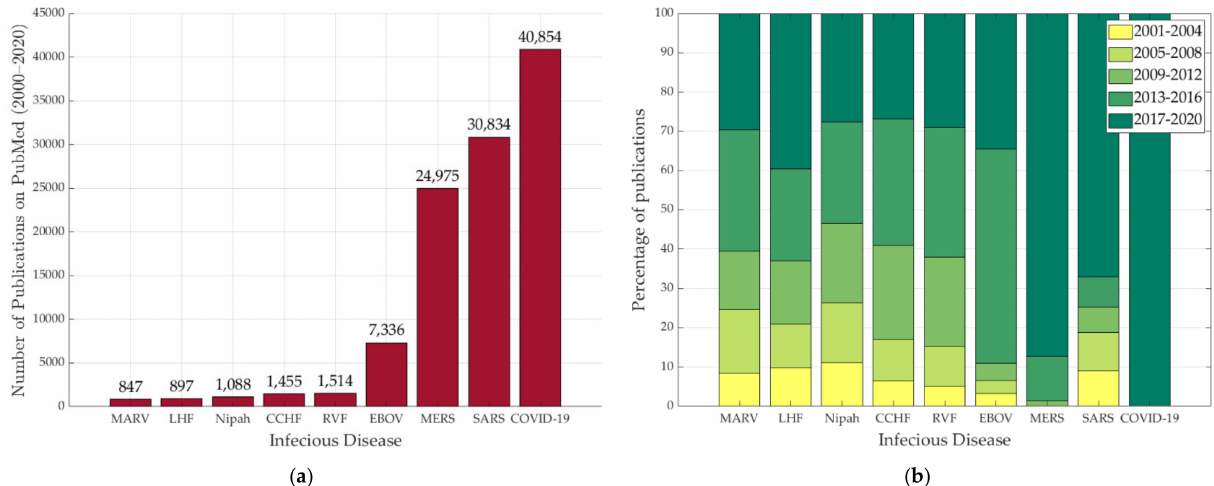
Figure 1. Statistics on publications for each disease for the period of 2000–2020, (Source: PubMed search results; search terms: “COVID–19”, “severe acute respiratory syndrome”, “middle east respiratory syndrome”, “ebola virus disease”, “rift valley fever”, “Crimean-Congo hemorrhagic fever”, “nipah virus”, “lassa fever”, “marburg virus disease”). ( a ) Number of publications mentioning each disease from the year 2000 to 2020; COVID-19 shows an unprecedented spike. ( b ) Percentage of published research on each disease after normalization during five four-year periods to show the periods at which certain topics received the highest